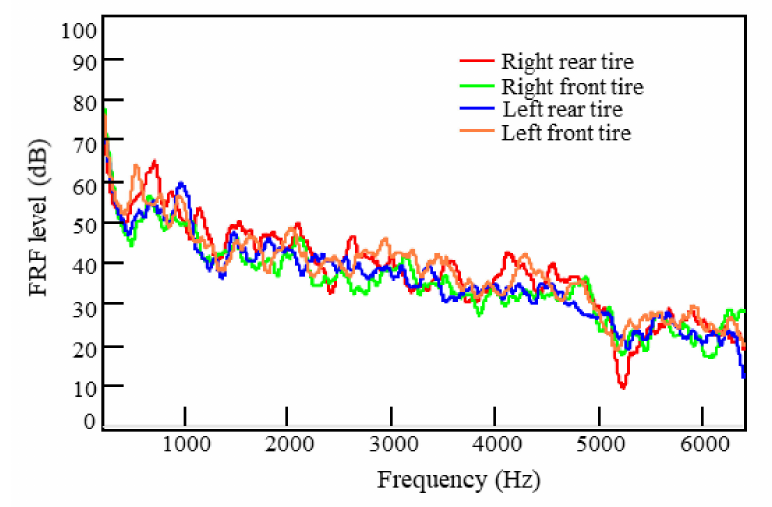
Figure 7. Measured spectra of the noise transfer functions of the